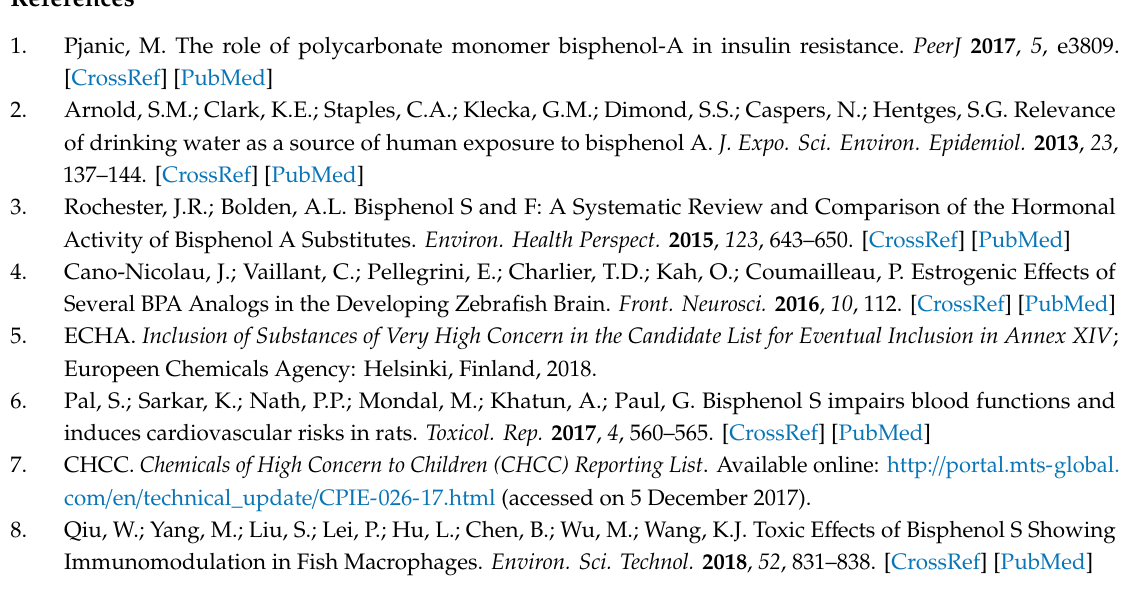
Supplementary Material Table S1: Growth conditions and media. Supplementary Material Table S2: Metaproteomics. Supplementary Material Table S3: MSqRob protein report. Supplementary Material Figure S1: pH and redox potential of CIM during the bioreactor run (quality control). Supplementary Material Figure S2: Volcano plot. Supplementary Material Figure S3: SCFA concentrations. Supplementary Material Figure S4: Relative protein abundance of SIHUMIx